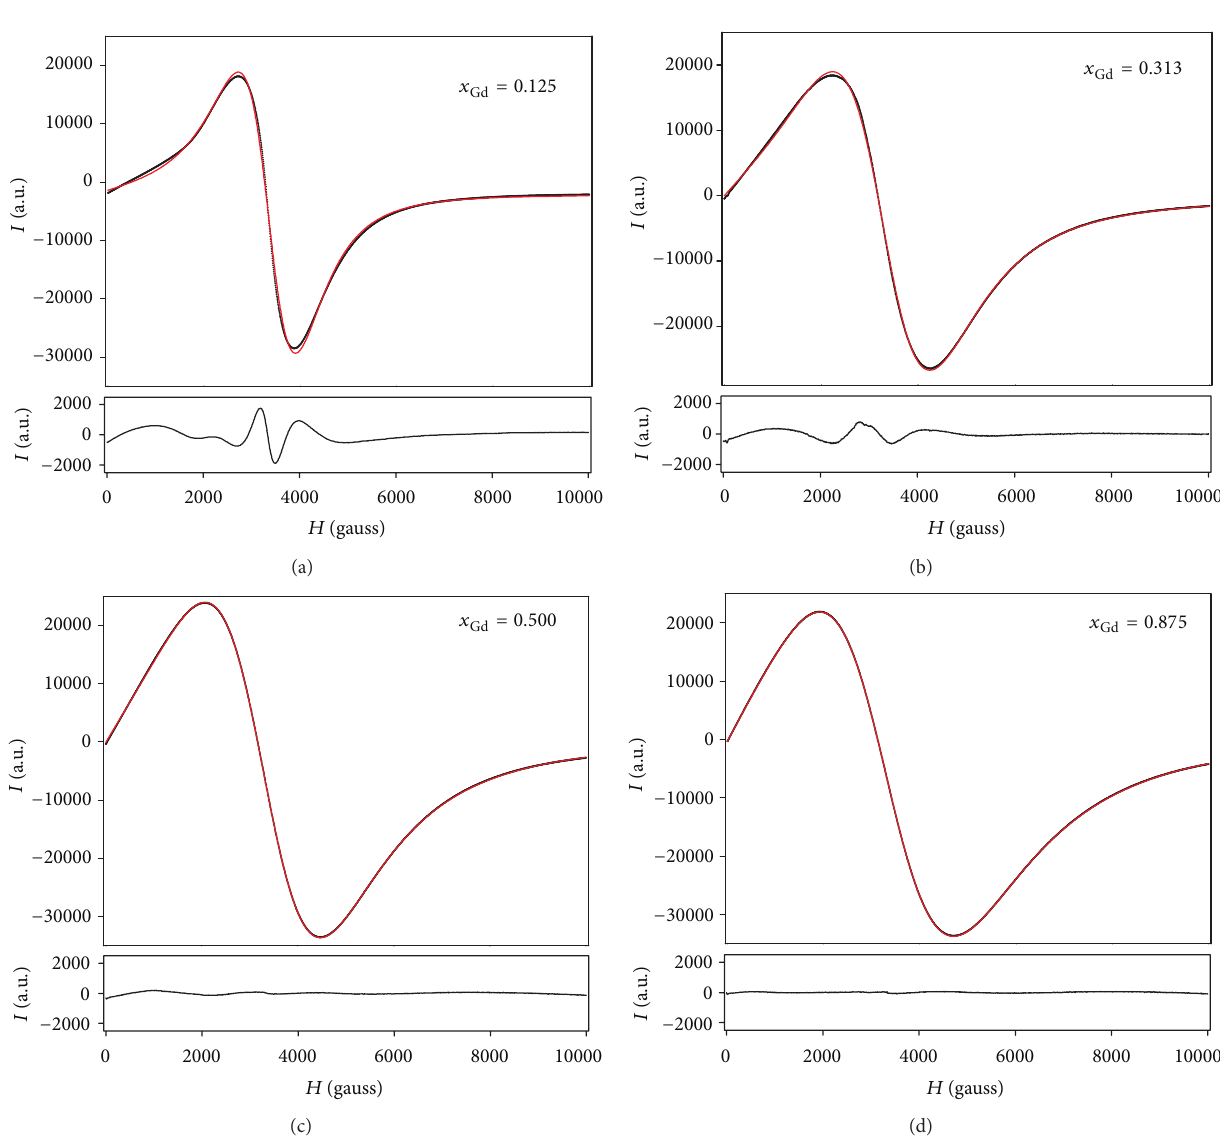
Figure 2: Dysonian fits of ESR lines for samples with 𝑥 curves (red on line). The differences are at the